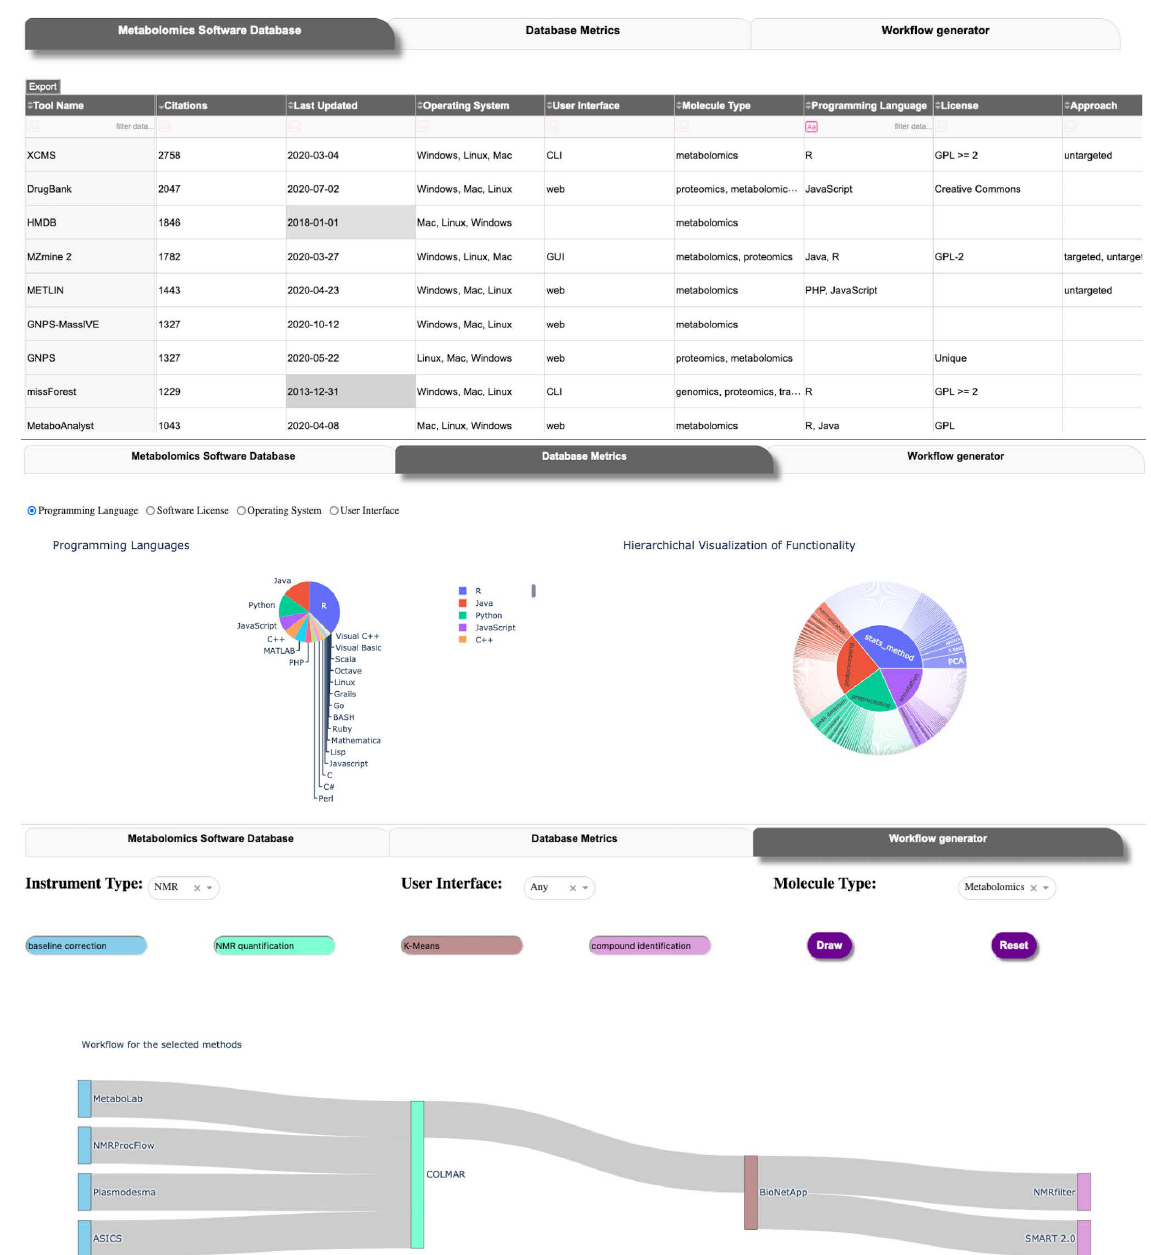
Figure 2. User interface of MSCAT. Top : main table view. Middle : aggregate tool data visualization. Bottom : work- flow